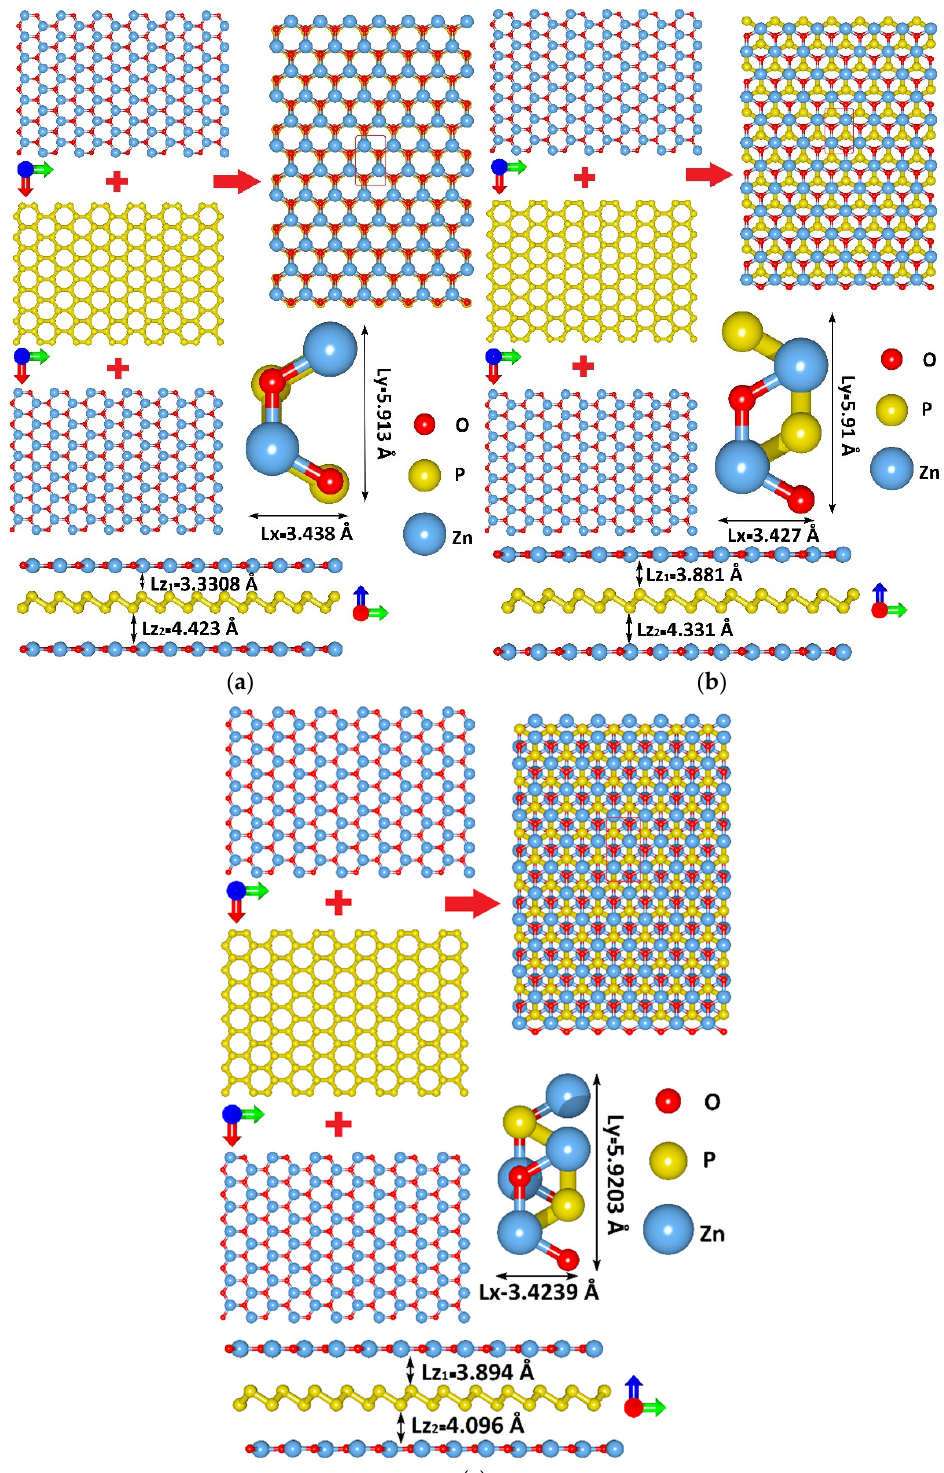
Figure 1. The process of constructing atomistic model of van der Waals ZnO/BlueP/ZnO heterostructure with AAA ( a ), ABA ( b ), and ABC ( c ) stacking configurations.